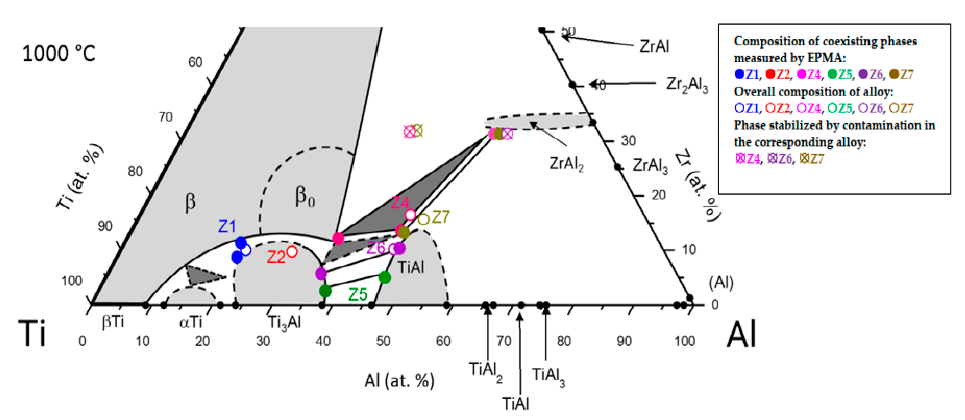
Figure 1. Partial Ti—Al—Zr isothermal section at 1000 °C. Table 3. Compositions and lattice parameters of the coexisting phases and impurity contents of samples annealed at 1000 °C. Data for HT represent the duration of heat-treatments; data shown in italics are from HE-XRD; phases marked with an asterisk (*) formed during quenching.